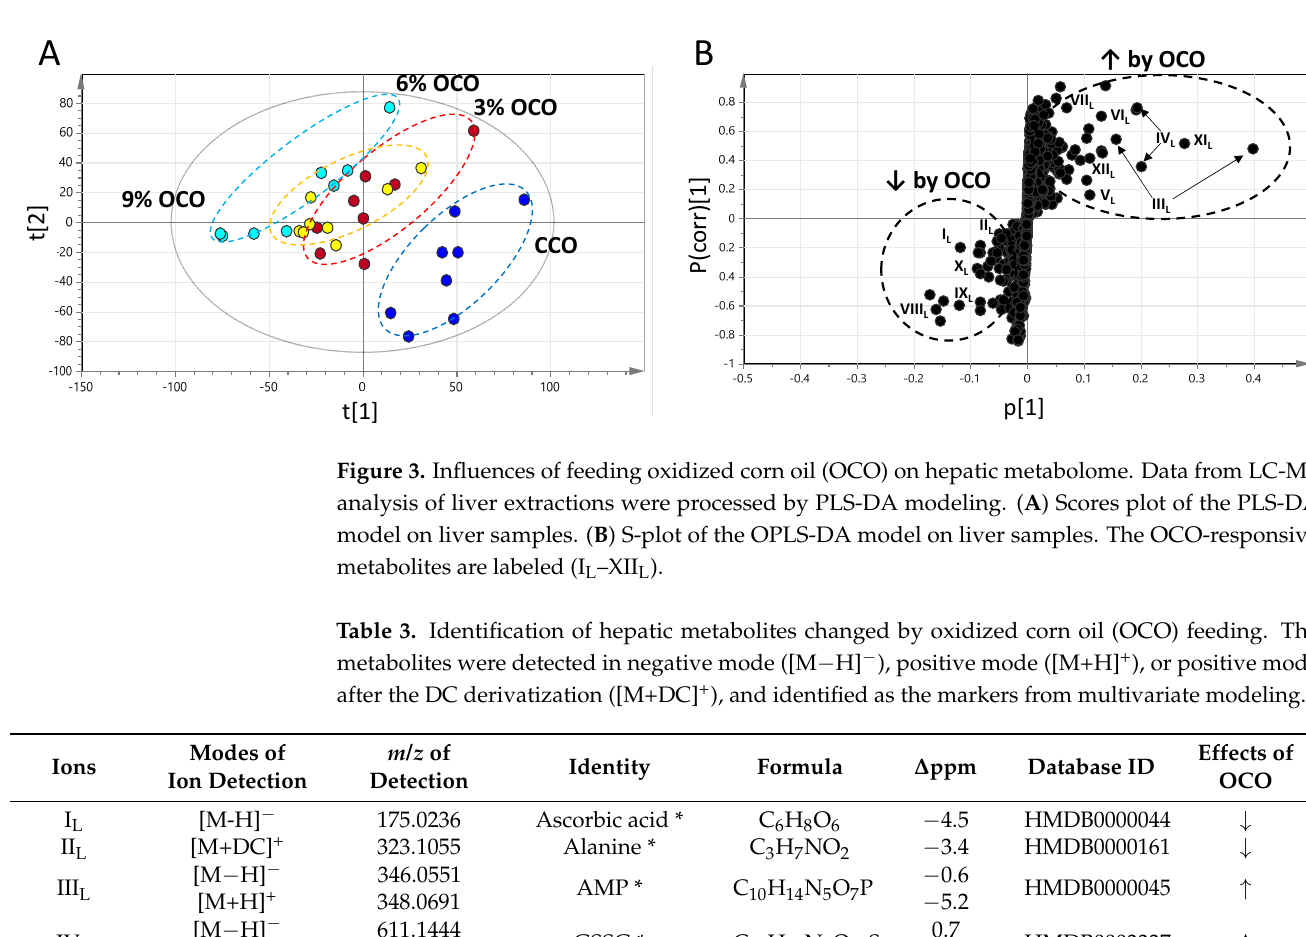
Figure 2 . Concentrations of oxidized corn oil (OCO)-responsive amino acids in the liver and their correlations with serum concentrations. Hepatic concentrations of glutamate ( A ), alanine ( B ), and carnosine ( C ). Value = mean ± SEM (n = 8 pigs/group). * p < 0.05 from one-way ANOVA followed by the Tukey post hoc test between control corn oil (CCO) and OCO treatments. The correlations between hepatic and serum concentrations of glutamate ( D ), alanine ( E ), and carnosine ( F ) and their significances were calculated by Pearson correlation analysis.